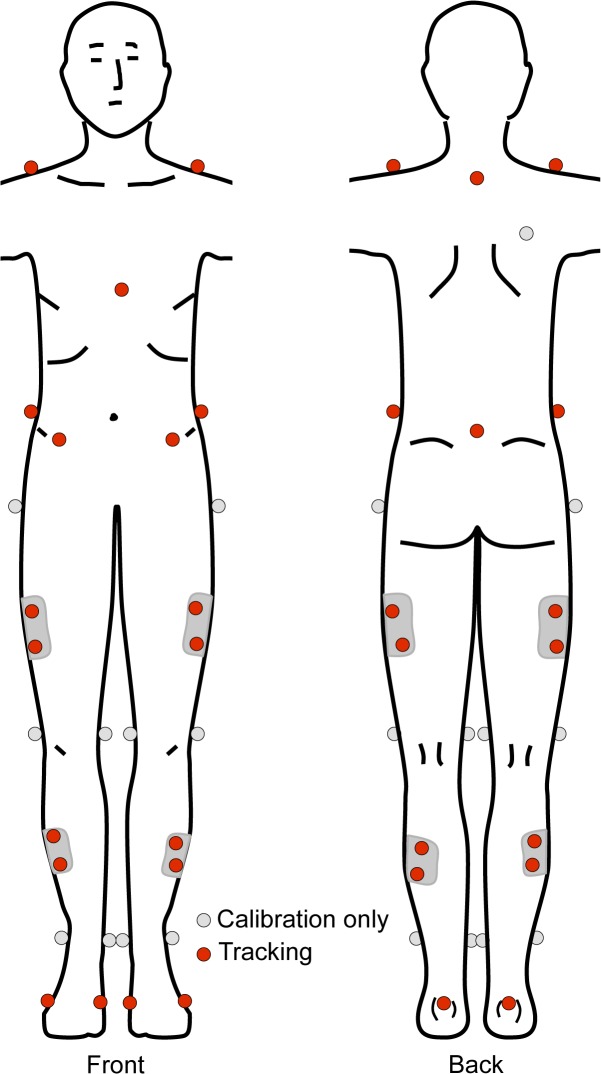
Representation of the 42 spherical, retro-reflective markers placed bilaterally over landmarks on the lower extremity, pelvis and trunk.